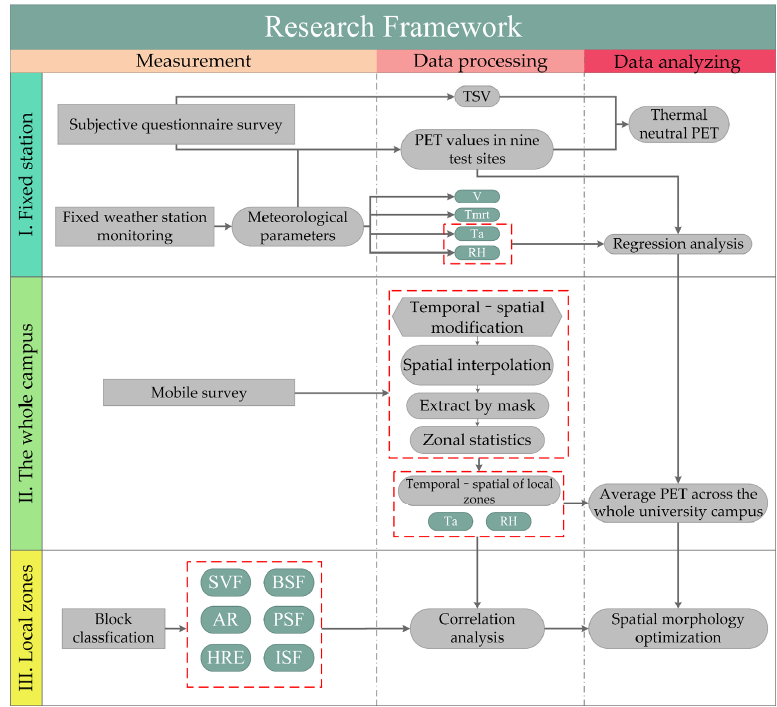
Figure 4. PET calculation process framework of the whole campus.